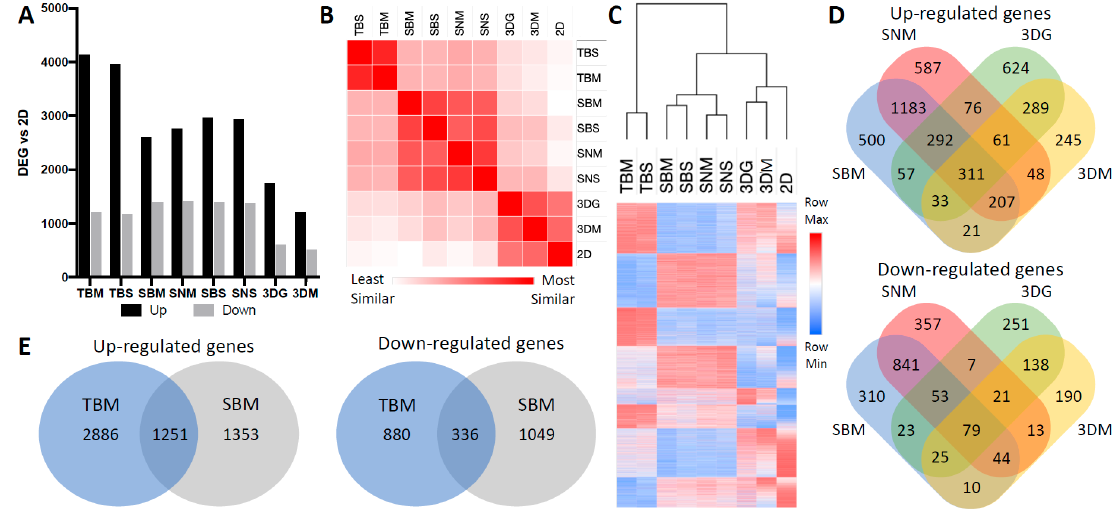
Figure 2. Transcriptomic variability of cancer cells under different culturing conditions. ( A ) Quantity of differentially expressed genes (DEGs) compared to 2D samples. DEGs were defined as greater than 2-fold change and FDR<0.05 (n ≥ 4). Cultured condition abbreviations: TBM: whole T umor from